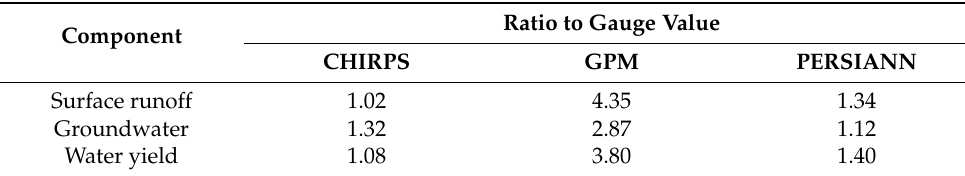
Table 9. Ratio of water balance components of satellite data products compared to those of rain gauge.